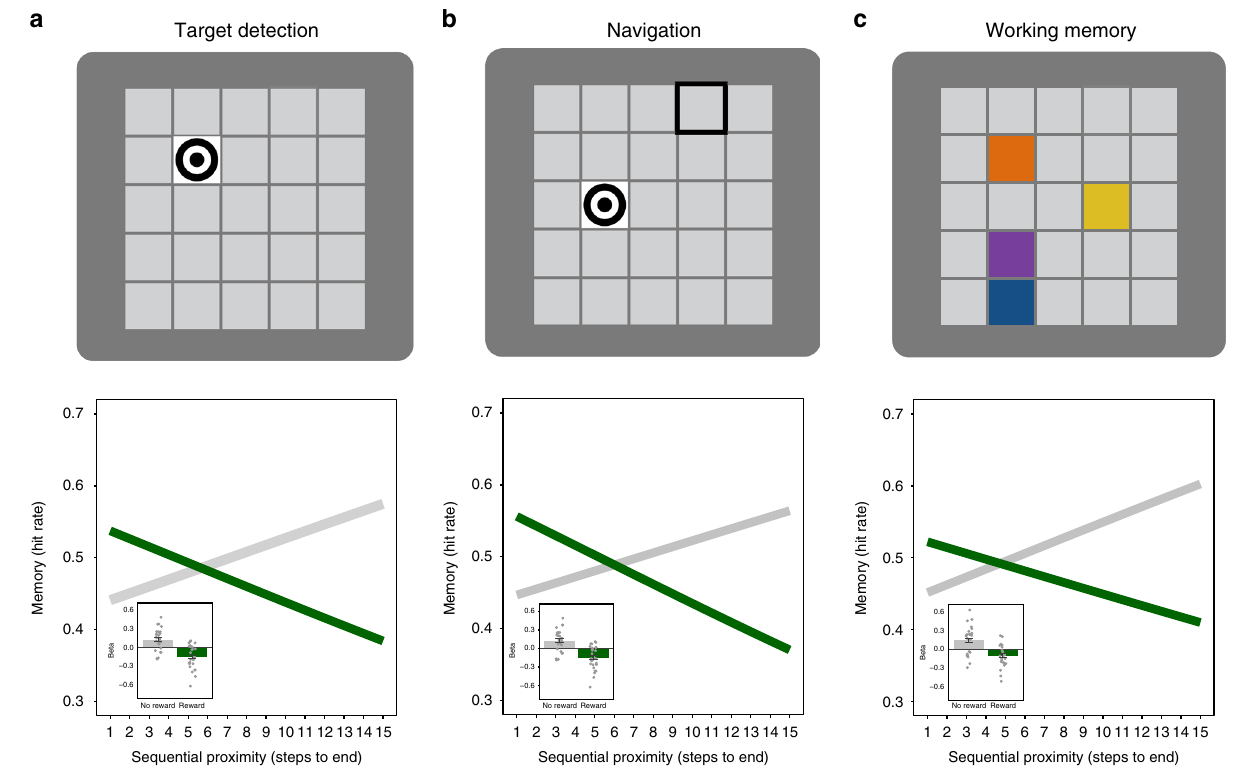
Fig. 4 Reward proximity effect is not due to strategic rehearsal. (Experiment 3) To rule out the possibility that the reward proximity effect was due to strategic rehearsal during the rest intervals, we conducted a follow-up experiment in which participants completed one of three distractor tasks during the rest breaks. a In the target detection condition ( n = 27), participants were instructed to make a key response every time a target image appeared in a maze square, but not when a lure image (a dark grey square) appeared (top). Despite the distractor task, we found that rewards retroactively modulated memory, such that participants were more likely to remember objects that were more proximal to the reward (bottom). b In the navigation condition ( n = 27), participants used the arrow keys to navigate to a target (top). We again replicated the reward proximity effect. c In the working memory condition ( n = 23), participants were presented with a target (a con fi guration of four randomly chosen colours in four randomly chosen squares) at the beginning of the rest interval and were instructed to make a key response to every presentation of this target con fi guration, but no responses to non-target con fi gurations (other combinations of colours and squares) (top). In the working memory condition, we again replicated the reward proximity effect (bottom). We did not fi nd a signi fi cant effect of distractor condition on the reward by proximity interaction (target detection condition vs. navigation condition× reward × proximity; target detection condition vs. working memory condition× reward × proximity (see Supplementary Table 3a for post hoc tests). The insets depict the beta coef fi cients for the reward and no-reward conditions. The error bars represent the standard error of the reward× proximity interaction and the dot plot overlay shows the reward and no-reward betas across